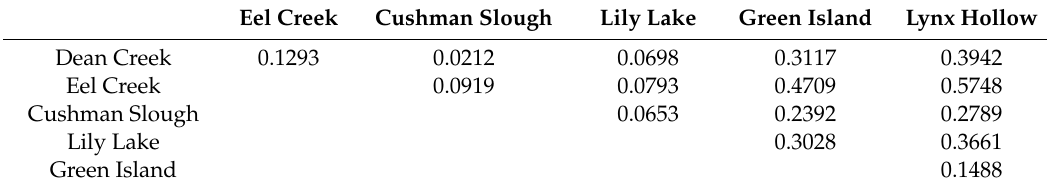
Table 3. Population genetic divergence (F ST ) among six threespine stickleback populations in Oregon based on 391 RAD-seq SNPs. The populations program in Stacks software was used for this output.